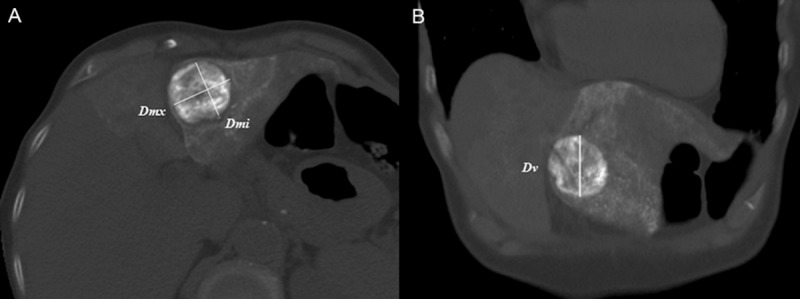
Measurement of three-dimensional (3-D) tumor diameters.Axial (a) and coronal (b) CT images best depicting index tumor serving in 3-D diameter measurements as follows: maximum diameter (Dmx) and perpendicular minimum diameter (Dmi) in axial image (a), and vertical diameter (Dv) in coronal image (b). Note: a preset bone window setting (width, 3000 HU; level, 500 HU) is applied to avoid beam-hardening artifact due to iodized oil retention by index tumors or surrounding parenchyma.